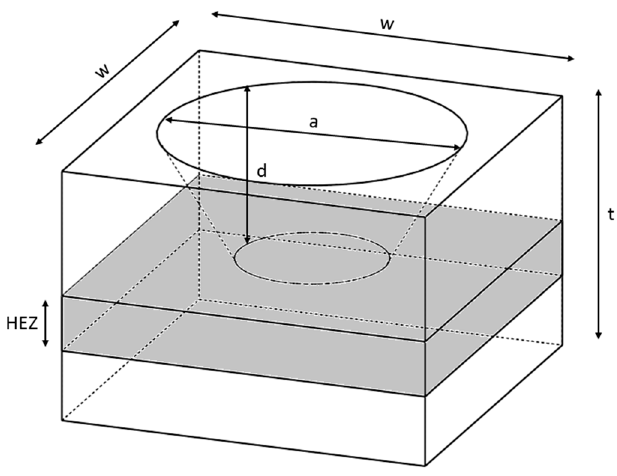
Figure 5. Schematic representation of the Representative Unit Cell (RUC). Table 3. Representative Unit Cell (RUC) dimensions (Top surface).